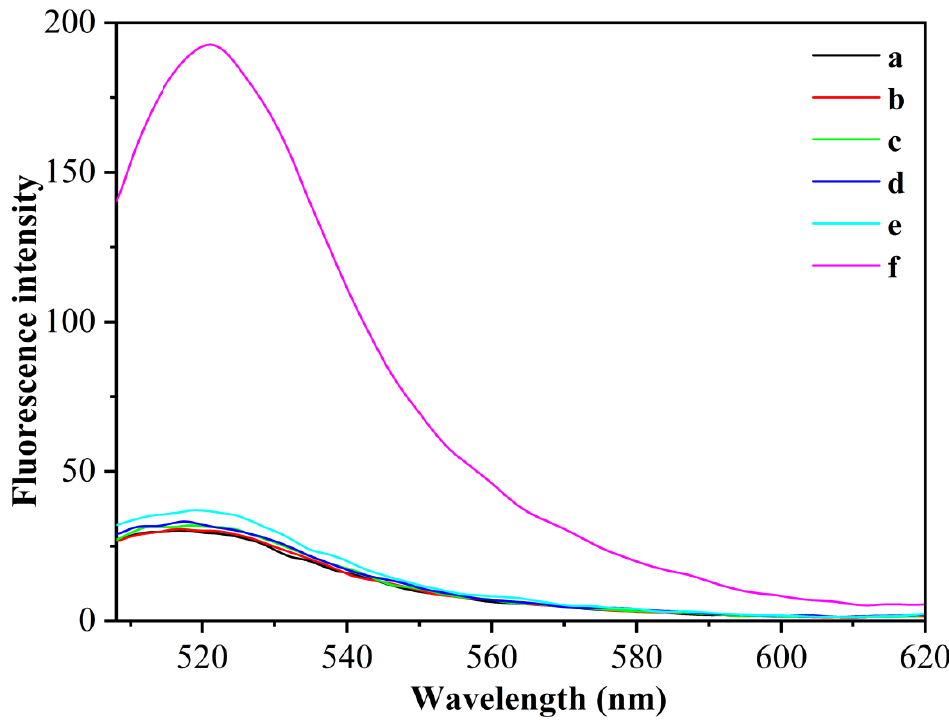
Figure 2. The fluorescence spectra with different sensing systems for the detection of CEA (1